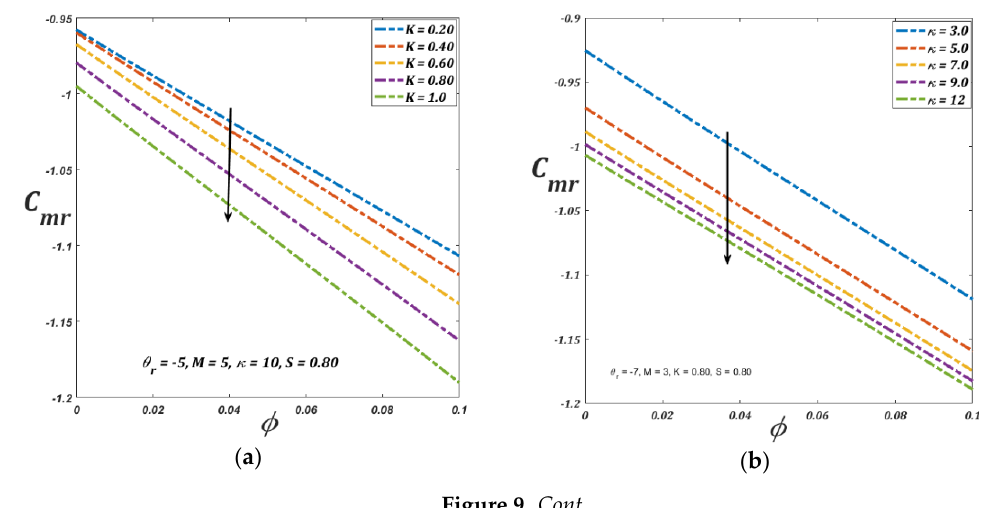
( c ) ( d ) ( e ) Figure 9. ( a ) Skin friction with micropolar parameter. ( b ). Couple stress coefficient with curvature parameter. ( c ). Couple stress coefficient with magnetic parameter. ( d ). Couple stress with variable viscosity parameter. ( e ). Couple stress with porosity parameter.